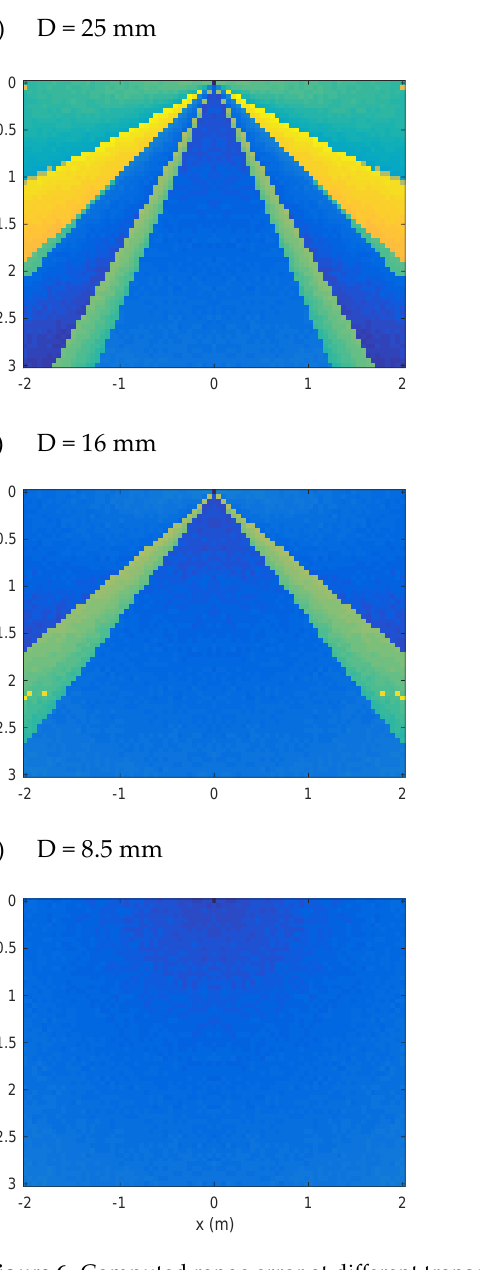
Figure 6. Computed range error at different transducer apertures D = {25, 20, 16, 13.1, 8.5, 6} mm in a dense grid of points (horizontal and vertical step = 0.05 m) belonging to the vertical 4 m × 3 m Section A (see Figure 1); it is possible to appreciate the progressive widening of the cone of the minimum ranging error going from D = 25 mm to D = 6 mm. For aperture values D = 8.5 mm and D = 6 mm, the low error region includes all the half-space in front of the transducer.